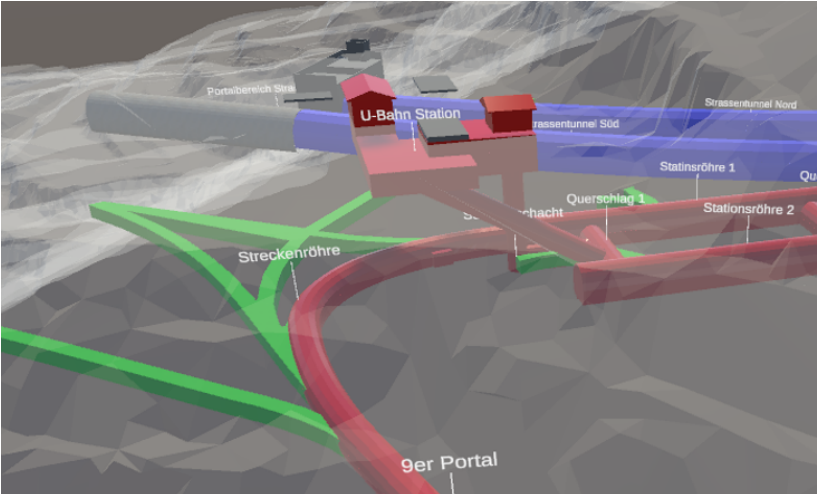
Figure 1. Subsurface structures pose high challenges to navigation systems due to changing distances, narrow spaces, and multiple levels without visual connection. The illustration shows a part of the Zentrum am Berg experimentation facility, where the field tests were conducted. (Picture: